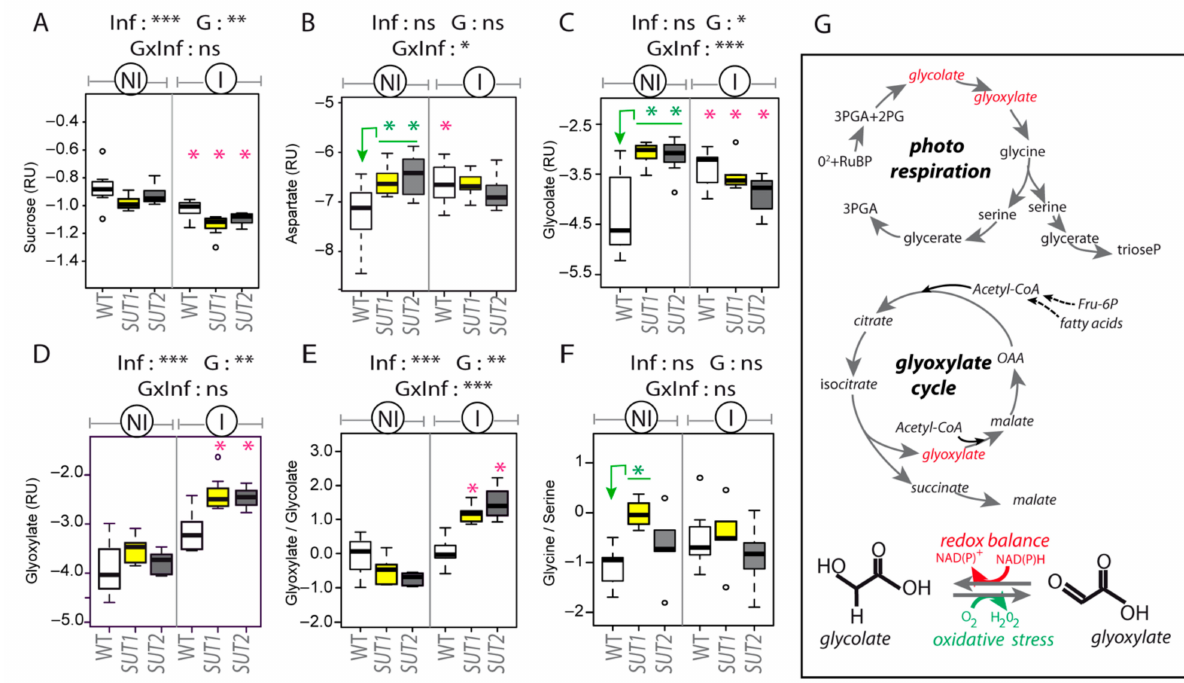
Figure 8. Main variations in the metabolite contents of phloem sap-enriched exudates in response to the infection. ( A – F ) Boxplots with the contents in the exudates from the L3 leaf of ( A ) sucrose, ( B ) aspartate, ( C ) glycolate and ( D ) glyoxylate and the content ratios for ( E ) glyoxylate-to-glycolate and ( F ) glycine-to-serine. Noninfected plants: NI, Infected plants: I and RU: relative units for content, plotted on a log 2 scale. The box and whisker plots show the distribution of the biological replicates. Inside black lines represent medians, top and bottom ends of the boxes represent the first and the third quartiles, respectively, and whisker extremities (open circles) represent the maximum and minimum data points when different from the first and third quartiles ( n = 6–8). Above each boxplot, the significance of the effects due to the infection (Inf), genotype (G) and their interaction (G × Inf) (* p < 0.05, ** p < 0.01 and *** p < 0.001; ns, not significant). Inside boxplots in green, t -test comparing AS lines with WT for NI plants and, in red, t -test comparing I and NI plants for each genotype. ( G ) Glyoxylate can be produced either via photorespiration or via the glyoxylate cycle, the latter being a bypass of the TCA cycle. Glyoxylate and glycolate are reversibly converted by glyoxylate reductases (GLYR) and glycolate oxidases (GOX), reactions that are controlled by the redox status and contribute to the production of reactive oxygen species (ROS) and the conversion of NAD(P)H into NAD(P)+. 2-PG: 2 phosphoglycolate, 3-PGA: 3 phosphoglycerate and RuBP: ribulose